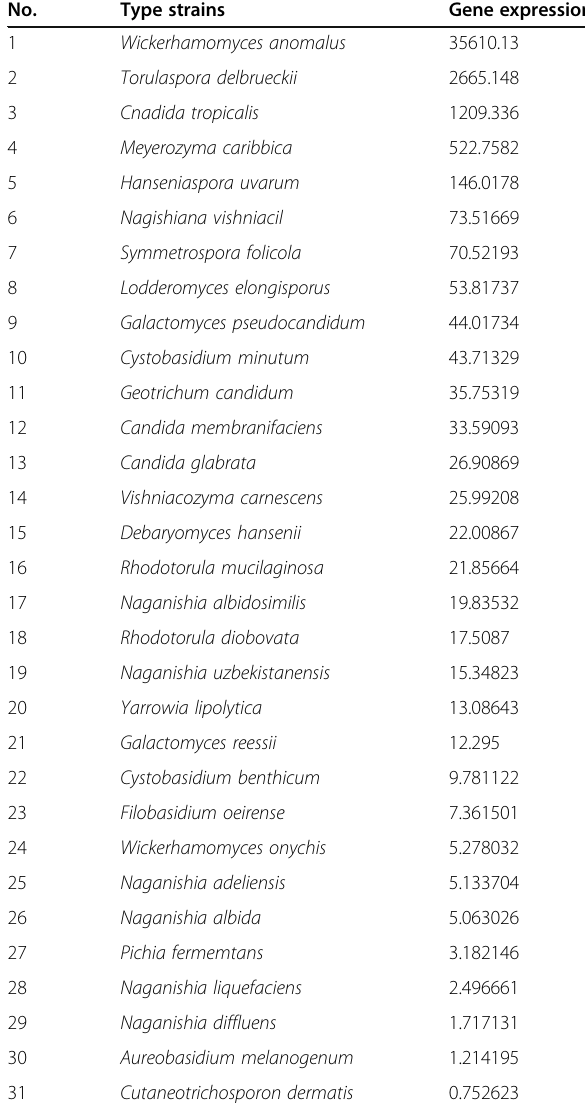
Table 4 Relative gene expression of M2 gene for 31 strains No.